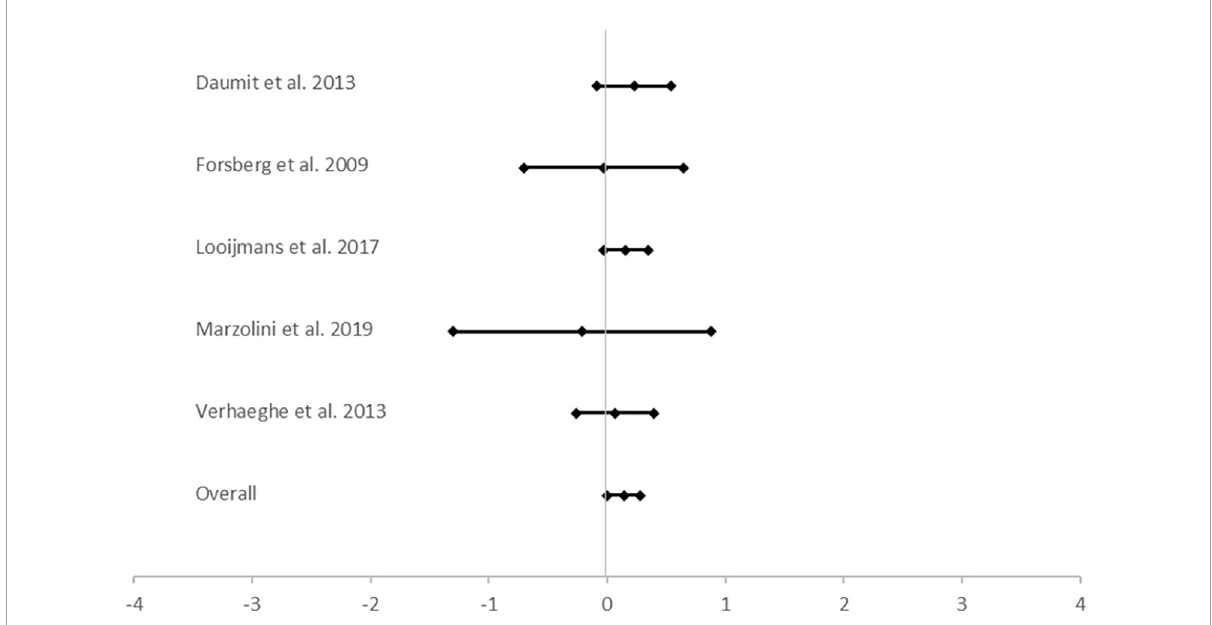
FIGURE2 Meta analysis on the effect of a lifestyle intervention on waist circumference. Hedge’s g < 0 favors control and Hedge’s g > 0 favors intervention.